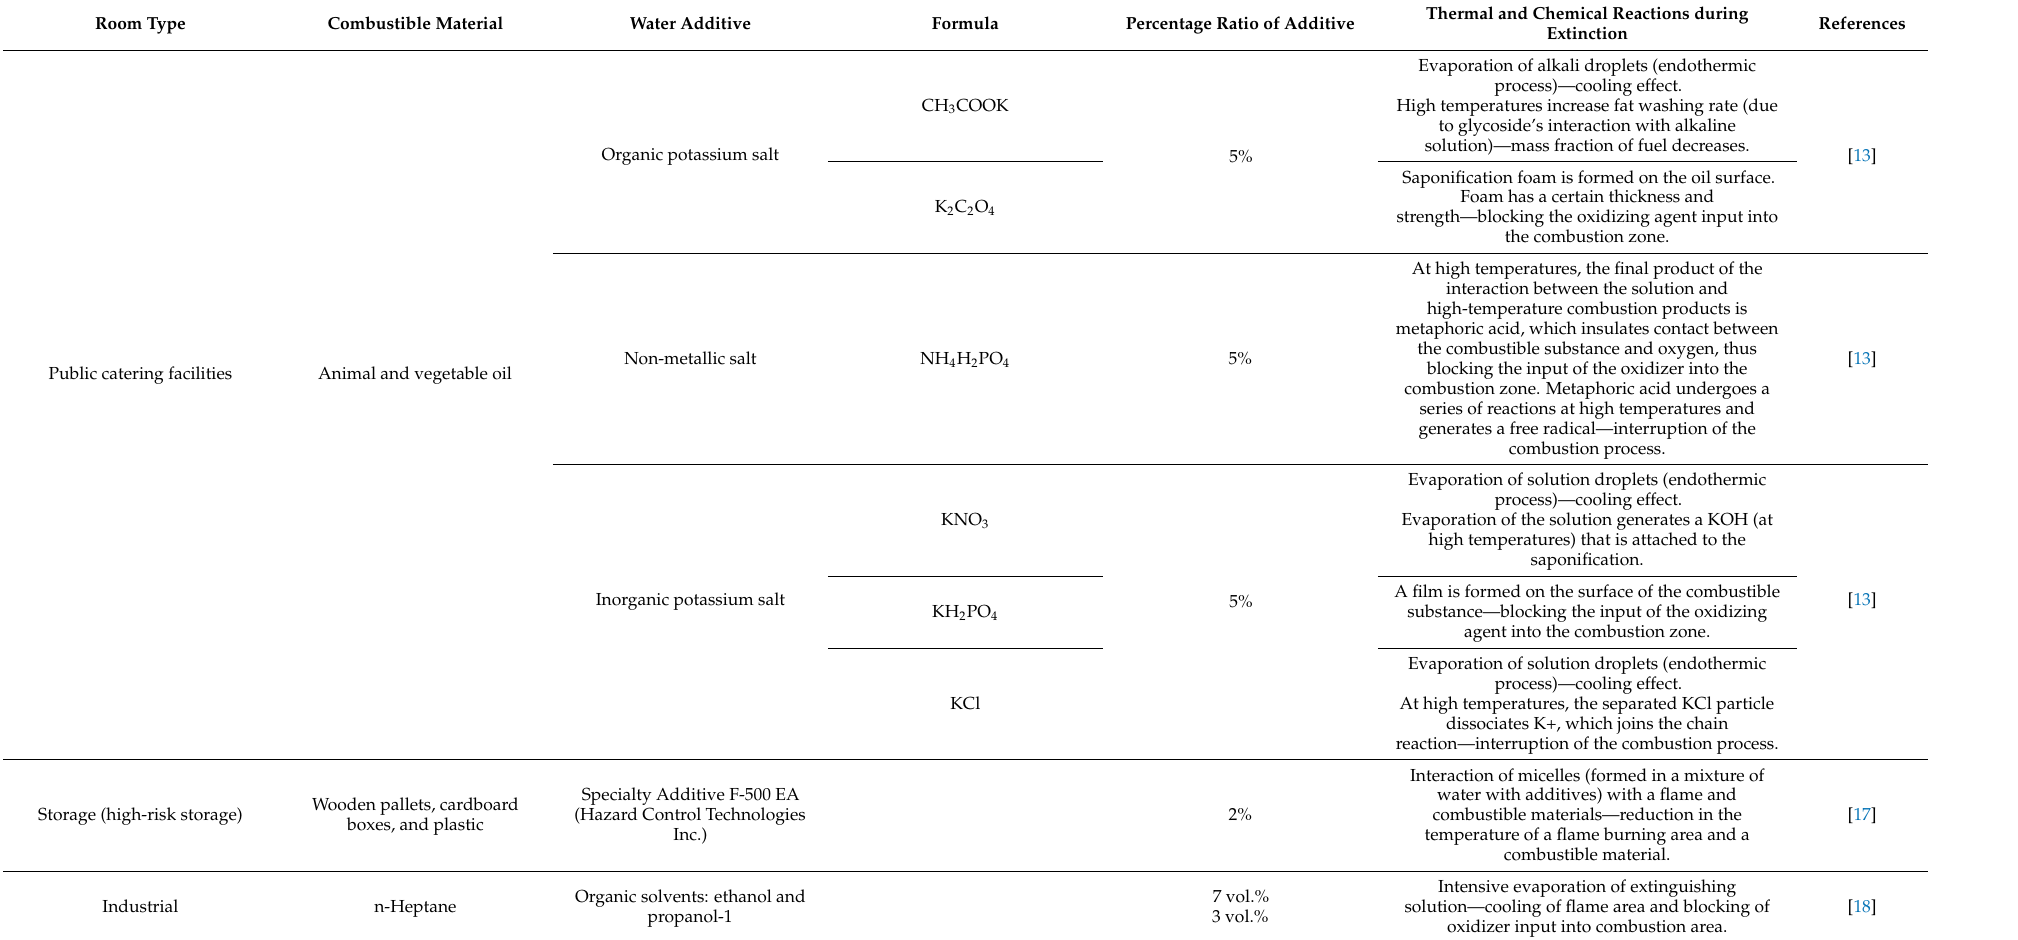
Table 2. Influence mechanisms of typical water additives used in